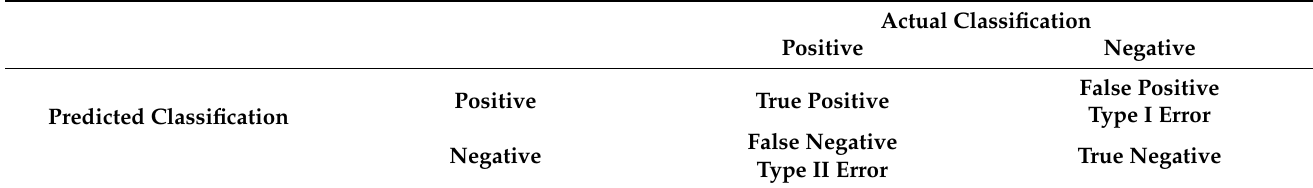
Table 4. Confusion Matrix for Binary Classification